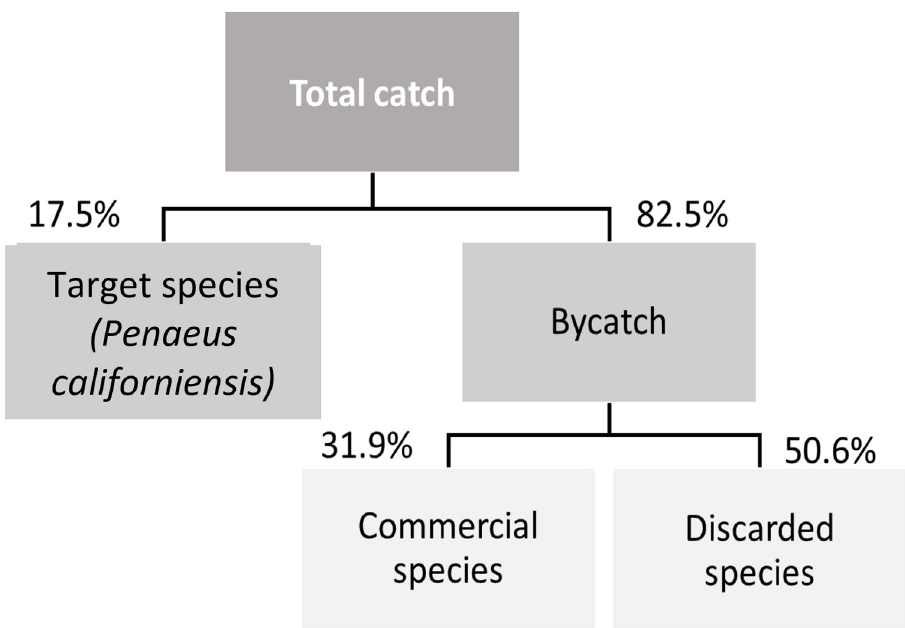
Fig 2. Catch composition showing the contributions of target species, bycatch, commercial species and discards to the total CPUE.